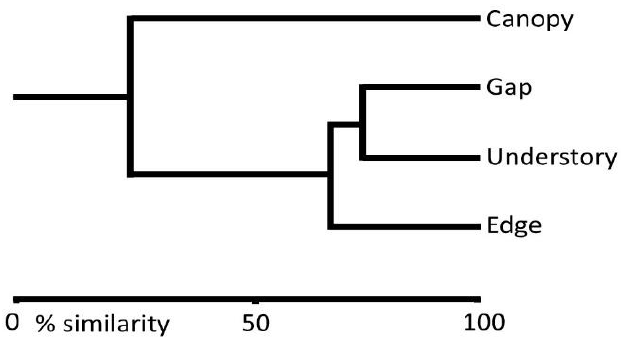
Figure 1. Bray–Curtis Cluster diagram on the similarity of fruit-feeding butterfly communities among habitats for butterflies trapped in fruit-baited traps in the Silent Valley National Park of the Western Ghats, India.